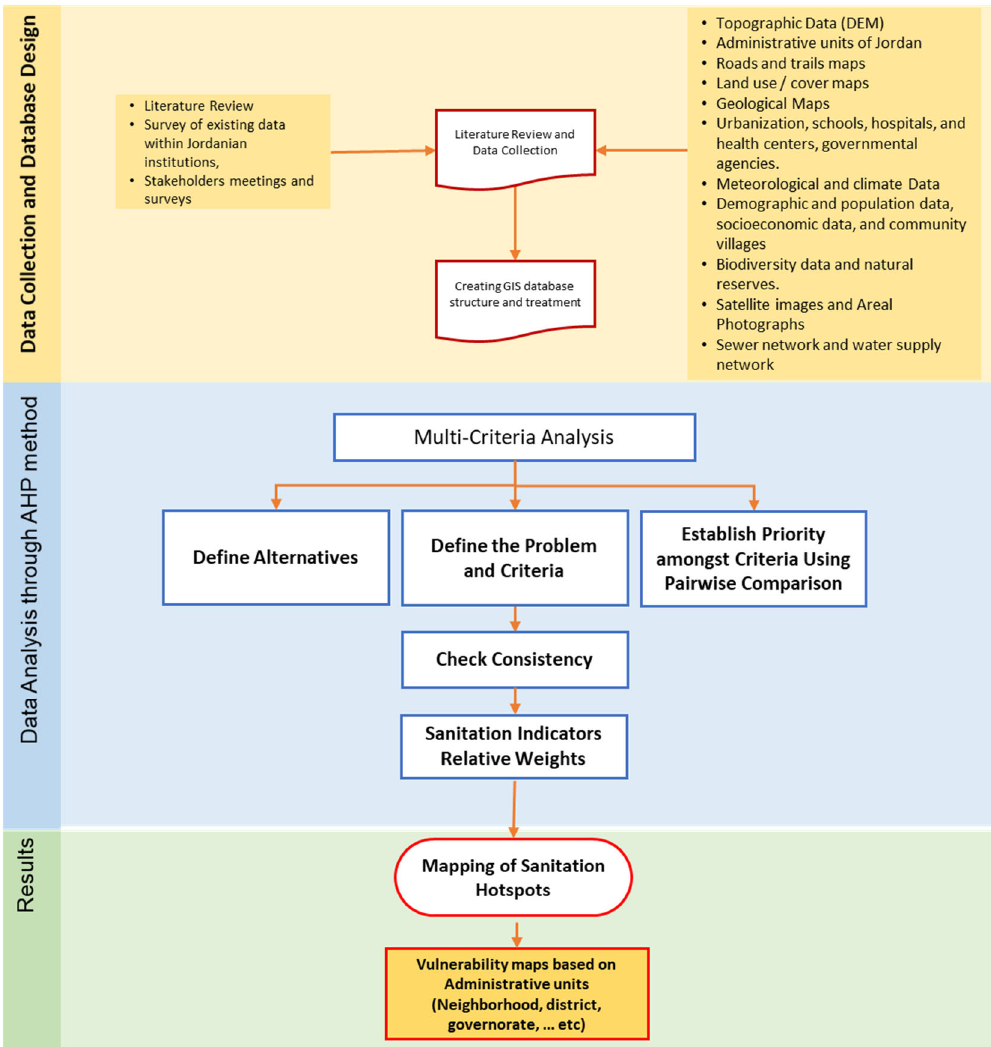
Figure 1. Schematic framework for the methodology of this study.